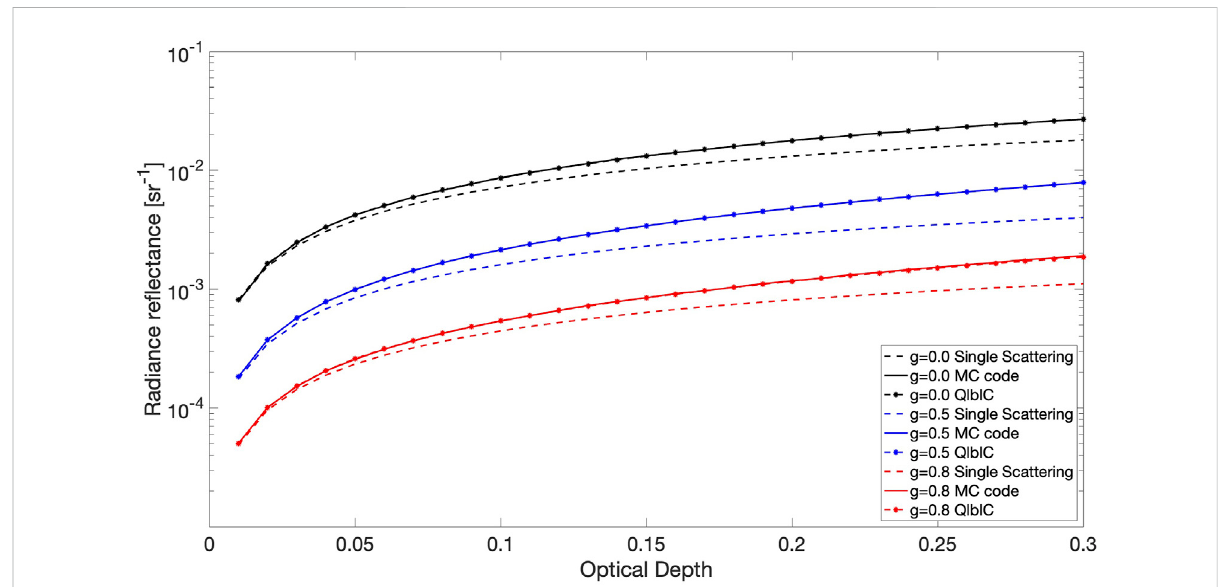
FIGURE 6 Radiance re fl ectance for a slab of non-absorbing particles scattering according to the Henyey-Greenstein phase function for two values of the asymmetry factor, g . TheAccuRTand MCresults are compared with thesingle-scattering predictions ofEq. 5.The results are shownas afunction of slab optical thickness, τ b , increasing from a small value to τ b =